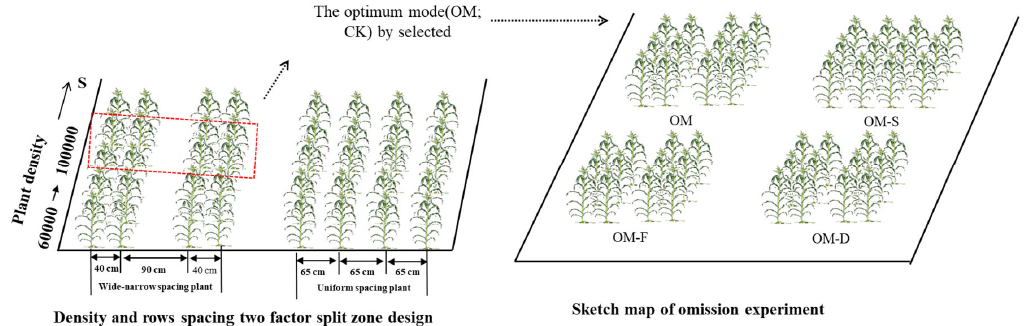
Figure 7. The sketch map of field experiment in 2017 to 2019, Based on the two factor split zone experiments, we identified the optimum mode (OM) as control treatment for omission experiment. The red box was used to show that the plant density (80,000 plants ha − 1 ) and plant spacing (wide- narrow plant spacing) of optimum mode (OM treatment) was selected based on the different plant density and plant spacing tests in the left sub ‐ graph.